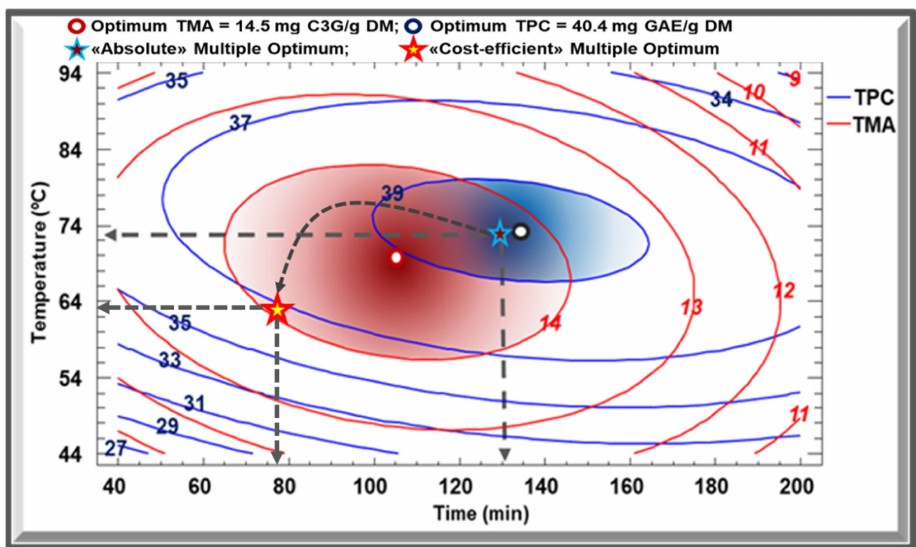
Figure 4. Overlap of TPC and TMA contour plots. The blue and red ellipses correspond to TPC and TMA optimal zones